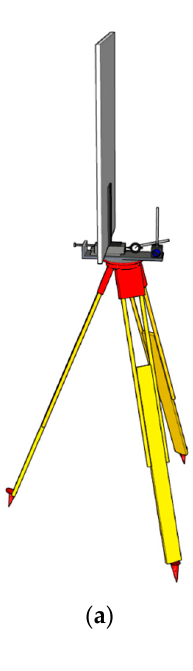
Figure 2. Scanning devices used in the experiments: ( a ) Riegl VZ-400; ( b ) Leica MS50.